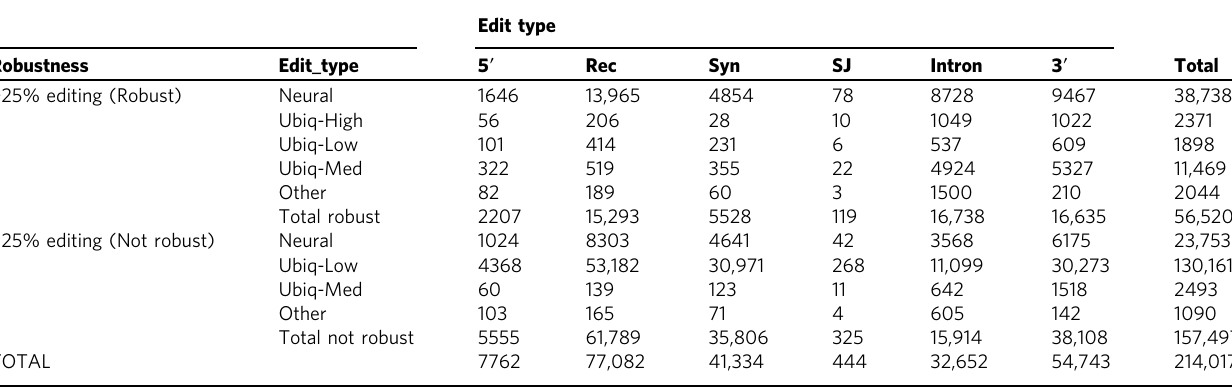
Table 1 The number of ADAR target sites found in different gene features subclassi fi ed by robustness and by edit